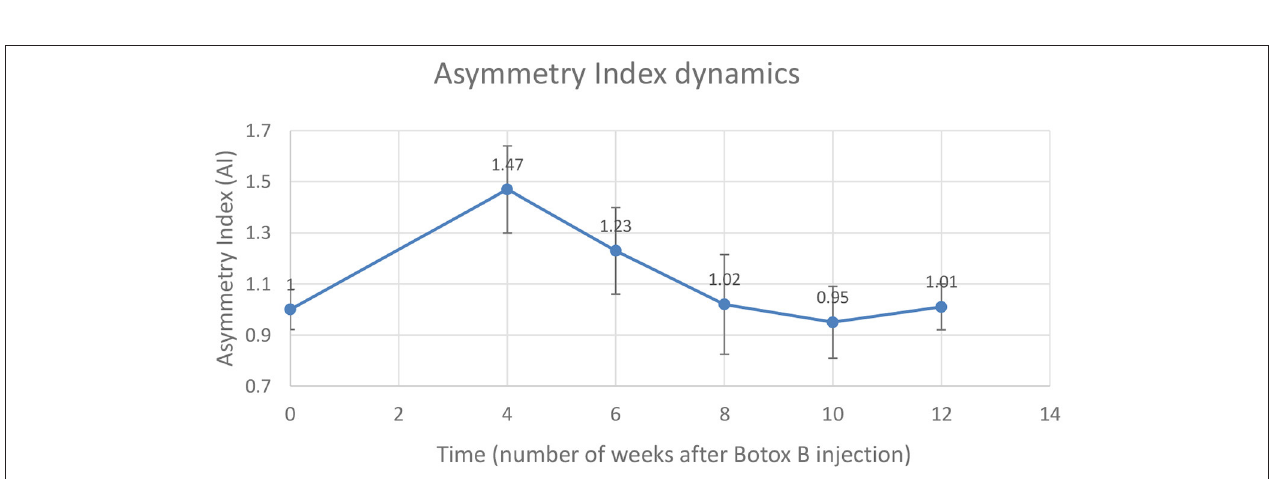
FIGURE 3 | Changes in the Asymmetry Index (AI) as a ratio of maximal vertical ground reaction on the injected left leg (LH) to the uninvolved right leg (RH).